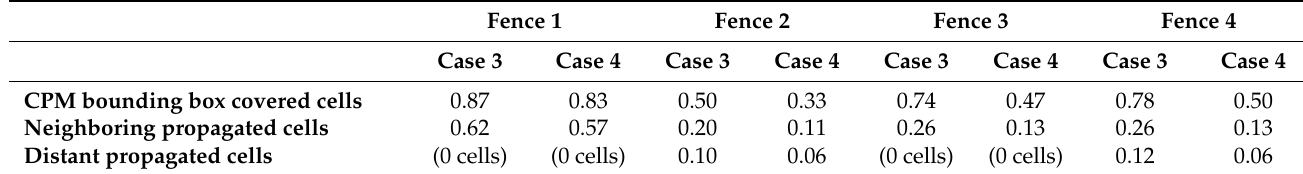
Table 3. Mean occupancy mass estimated for the